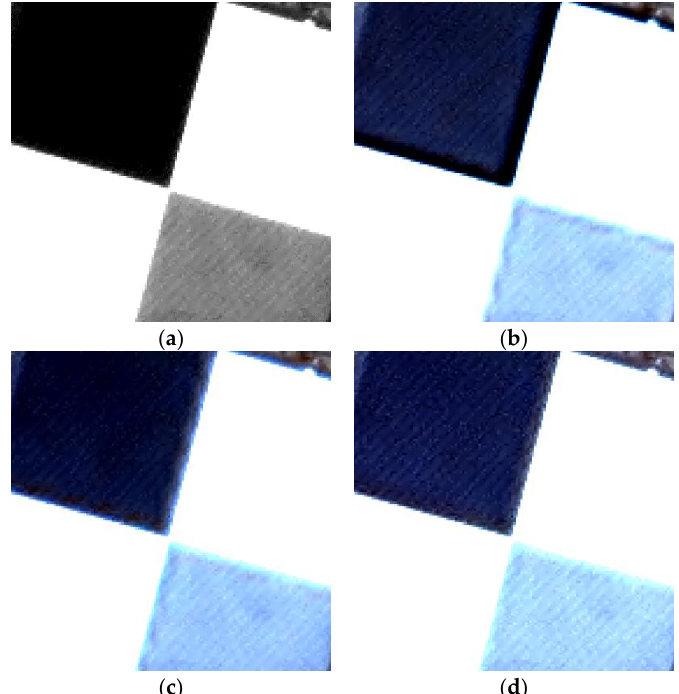
Figure 7. The details of the edge target according to each algorithm in the Baotou region: ( a ) panchromatic image; ( b ) resized multispectral image; ( c ) image pansharpened by the MTF-GLP; ( d ) image pansharpened by the GSA; ( e ) image pansharpened by the GFNDVI. Remote Sens. 2019 , 11 , x FOR PEER REVIEW